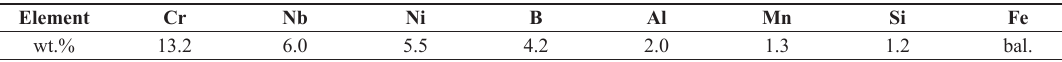
Table 1. Chemical composition (wt.%) of feedstock wire material. Element Cr